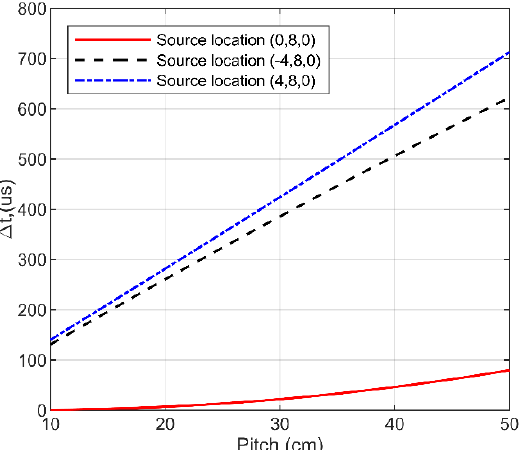
Figure 13. The obtained time differences Δ t versus pitch. The source is 8 m away in front (red) and 4 m to the right (blue) or left (black) sides.